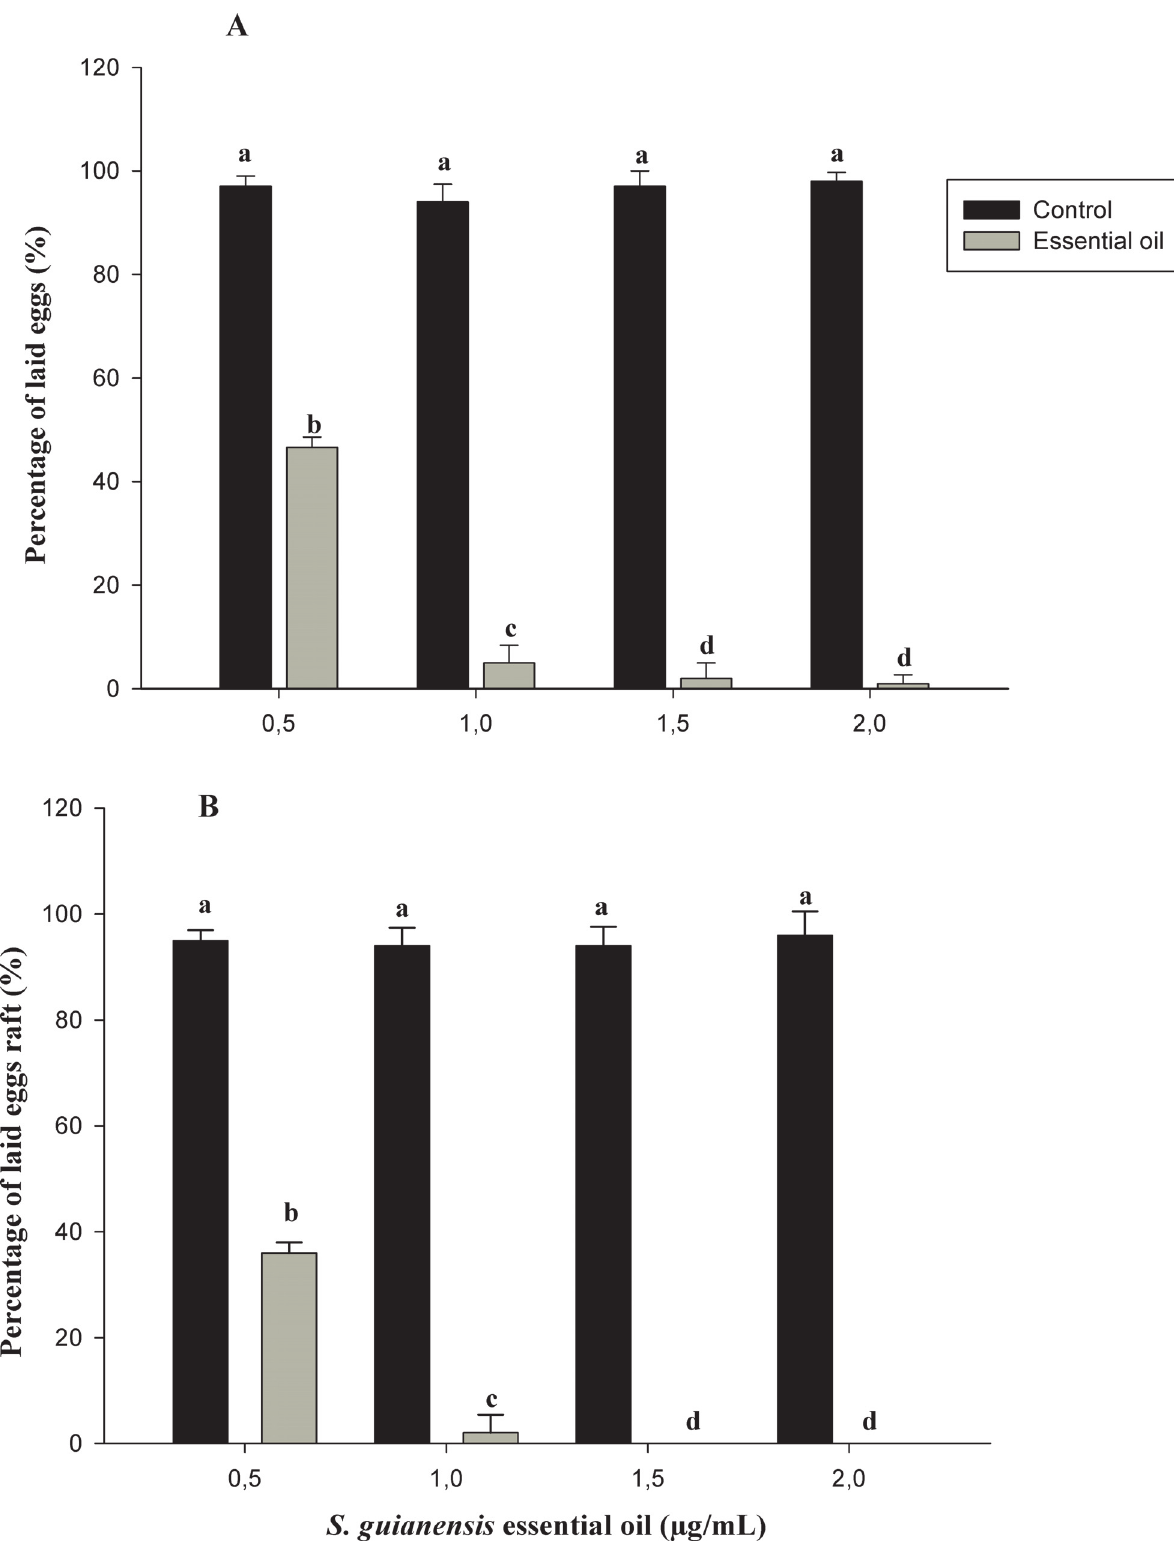
Figure 2. Average proportion of eggs and egg rafts laid in ovitraps of A . aegypti (A) and C . quinquefasciatus (B) treated with different concentrations of essential oils of S . guianensis . Control: Number of laid eggs ovitraps treated with water + DMSO. Different letters between columns indicate significant differences. Means followed by different letters are significantly different (P < 0.01). Analysis of variance followed by Tukey ’ s test. doi:10.1371/journal.pone.0116765.g002 PLOS ONE | DOI:10.1371/journal.pone.0116765 February 3,